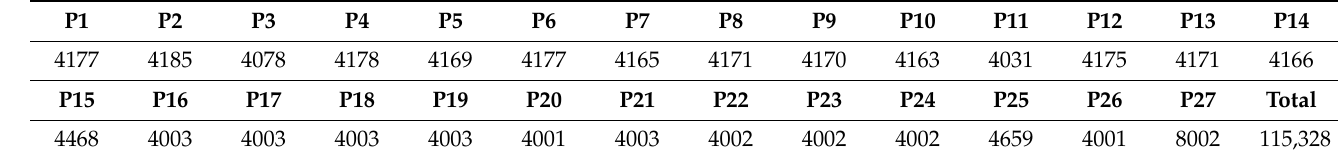
Table 5. Parameters for a considered family of